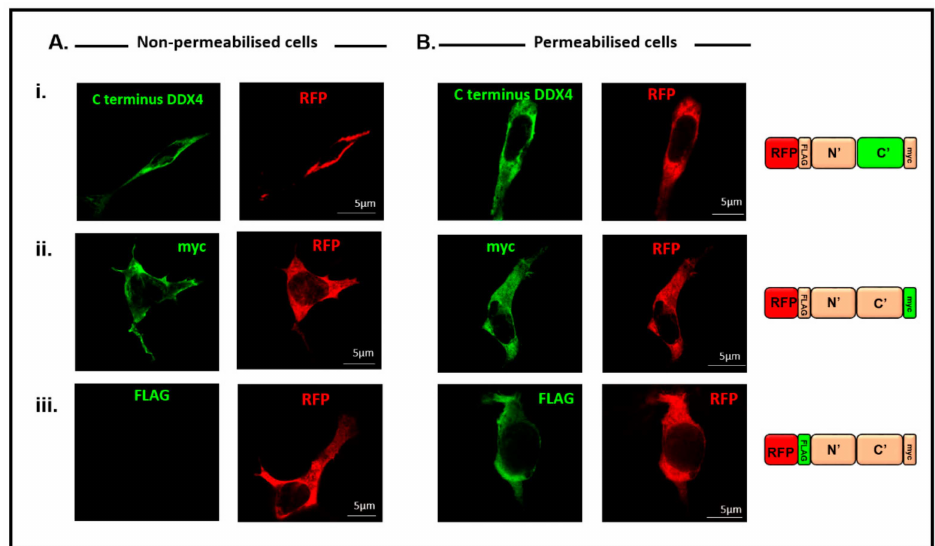
Figure 3. The C-terminus of DDX4 is expressed on the cell surface. ( A )(i) and (ii) Immunostaining with the C-terminus and myc antibodies (green) confirmed that DDX4 is expressed on the cell surface of transfected (red), non-permeabilised cells. (iii) The majority of non-permeabilised cells confirm that the N-terminus of DDX4 (FLAG tag) is intracellular as the FLAG tag could not be detected in non-permeabilised cells. Red fluorescent protein (red) confirms transfected cells (i), (ii) and (iii). ( B )(i) and (ii) The C-terminus of DDX4 (green) is observed throughout permeabilised cells. (iii) The N-terminus of DDX4 (FLAG tag, green) can be detected when cells are permeabilised. The colour schemes on the protein schematic mirror the fluorophores used for staining those particular regions of the corresponding protein. Scale bar, 5 µ m.